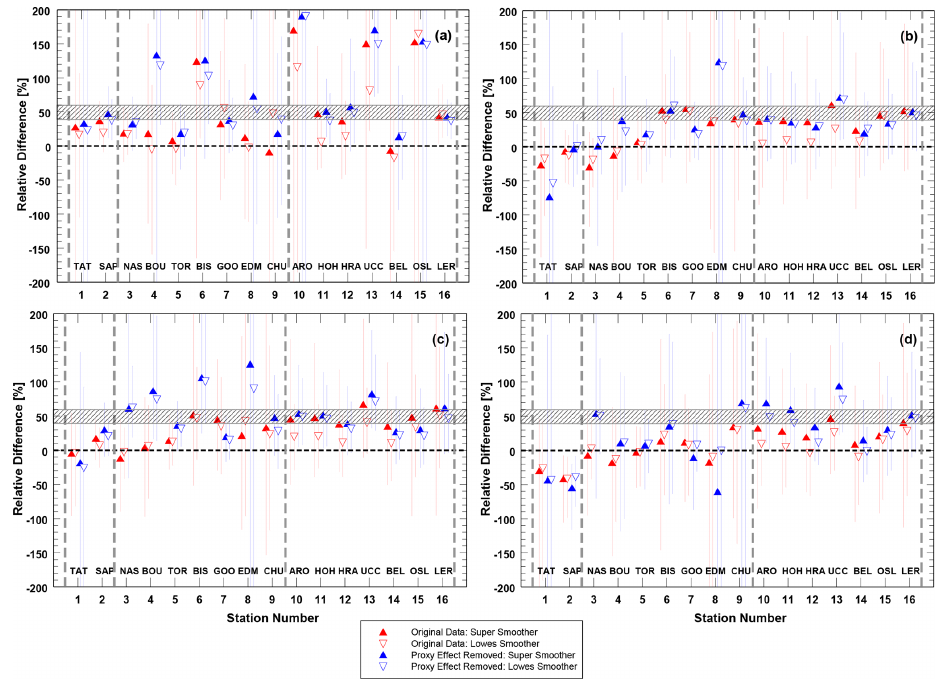
Figure A4. The same as Fig. A3 but for the ozone recovery index, ORI 2 (1997 ,